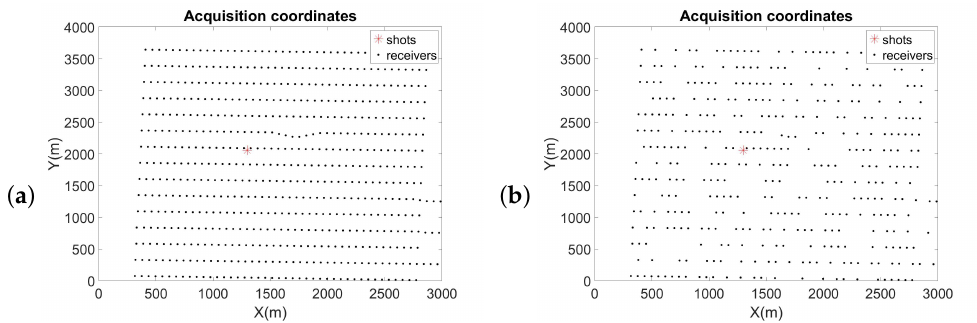
Figure 14. Geometry of the field data. ( a ) Initial distribution of the traces. ( b ) Distribution of traces after removing 41% of them.